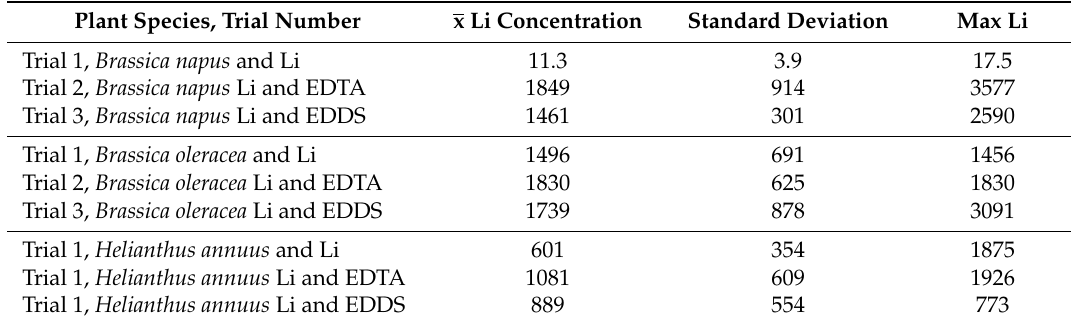
Table 4. x maximum Li levels, standard deviations and maximum levels of Li in plants from all 3 trials (units in